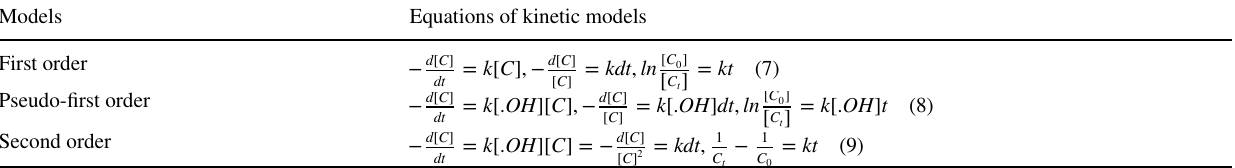
Table 2 The models of reaction kinetic and their equations Models Equations of kinetic